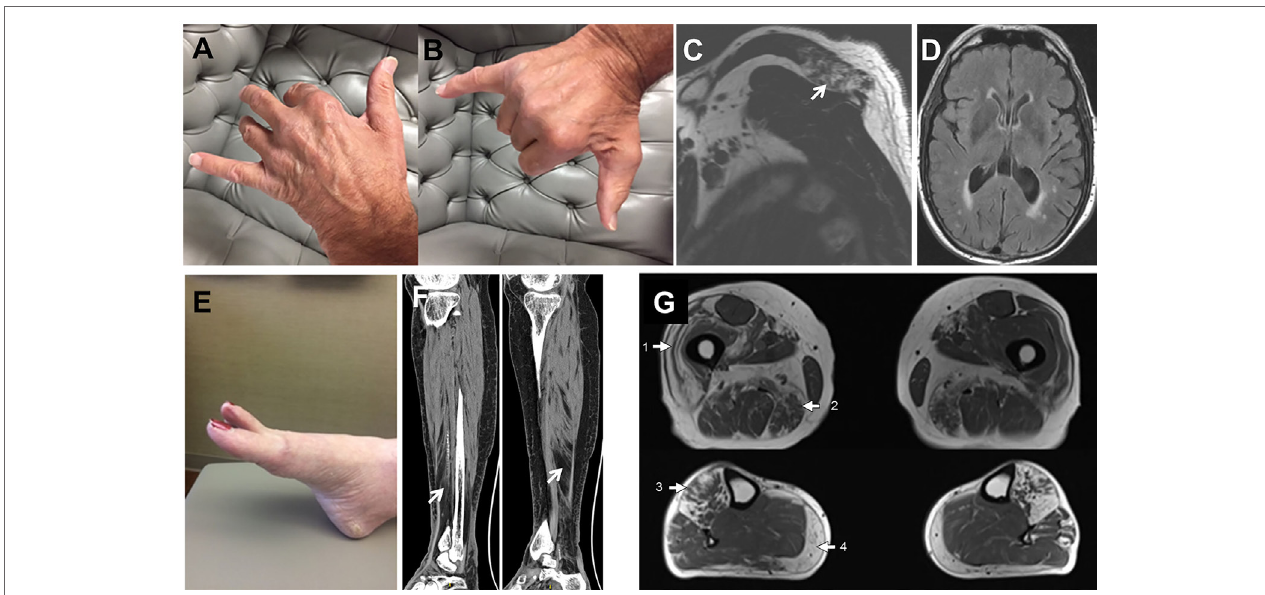
FigUre 2 | Patient’s photographs and radiological images. Proband 1 (a–D) . Photographs illustrating the predominant weakness of digit II to IV extensors with spared I and V digit extensors (a,B) . MRI images demonstrating focal fatty atrophy (arrow) involving the left posterior trapezius muscle (c) . T2 FLAIR brain MRI images showing mild generalized atrophy with patchy and confluent periventricular white matter hyperintensities suggestive of leukoaraiosis (D) . Proband 2 (e,F) . Photograph demonstrating the hanging big toe (e) . CT images revealing moderate-marked fatty atrophy involving the anterior compartment musculature of the right lower leg overlying the distal third of the tibia and fatty infiltration of the lower calf muscle (F) . Proband 3 (g) . Muscle MRI showing fatty infiltration of muscles in a geographic distribution, indicated by numbered arrows. The predominantly affected muscles include the vastus lateralis (1) and adductor magnus (2) in the thighs and anterior compartment muscles (3) and medial gastrocnemius (4) in the lower